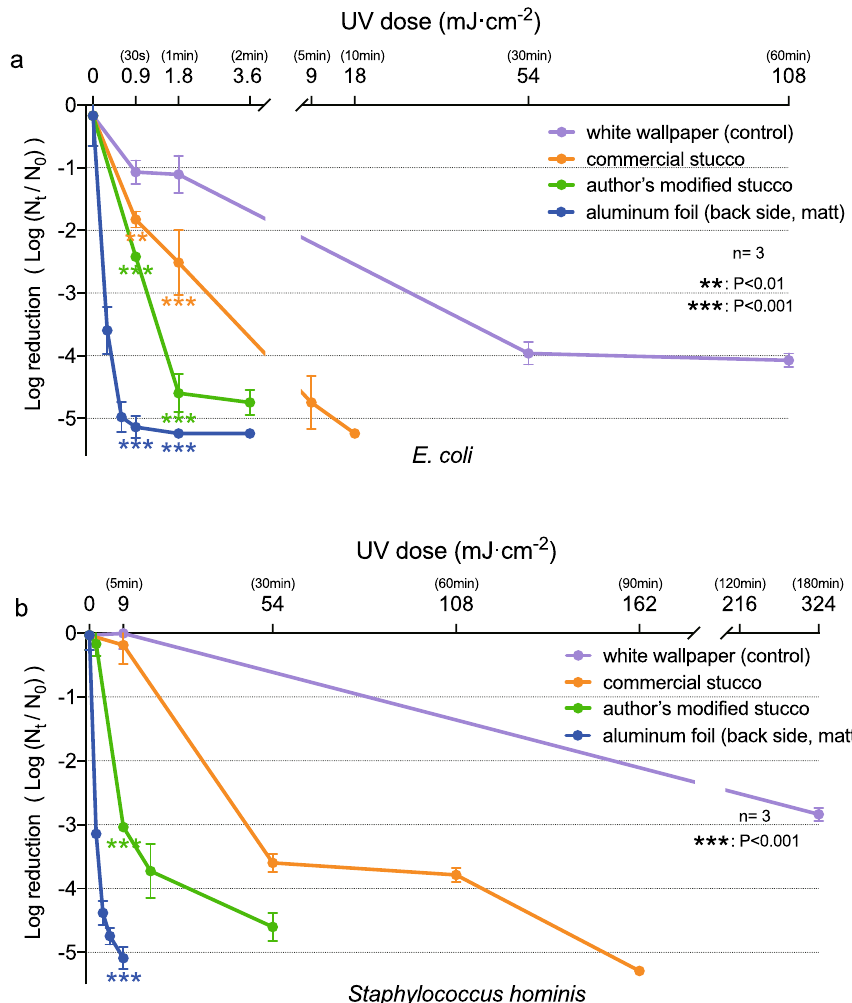
Figure 6. Log reduction (Log (N t /N 0 )) vs UV dose of UV-C reflected off various materials: the UV-C was irradiated to standard agar media applied with ( a ) E. coli and ( b ) S. hominis . UV dose is the UV intensity at a distance of 75 cm from the direct UV-C lamp (6 W, 254 nm). Data are presented as mean ± standard deviation. **p < 0.01, ***p <